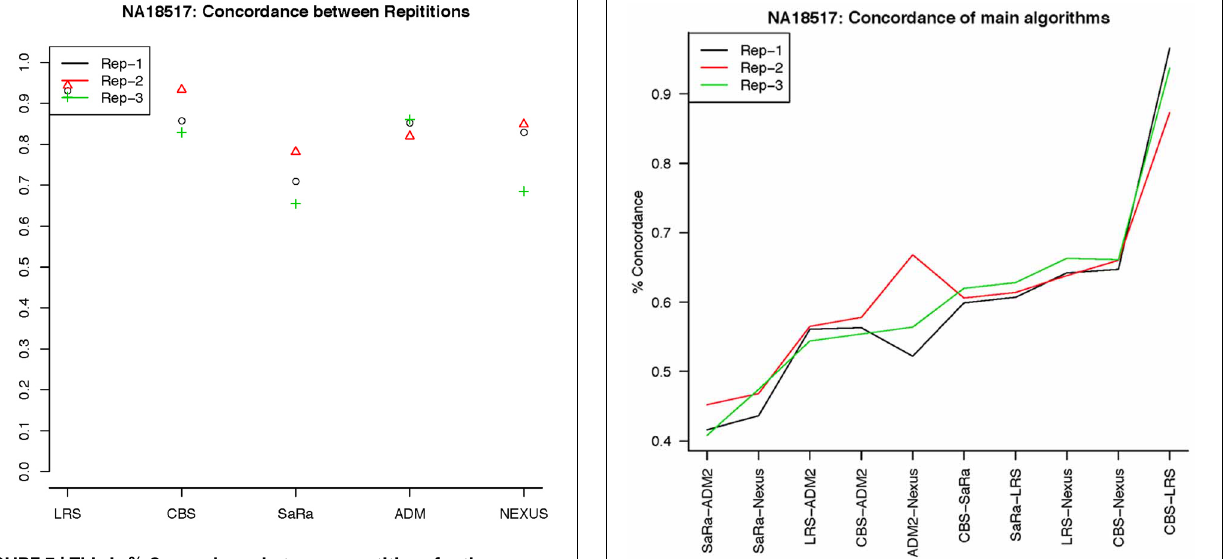
FIGURE 7 | This is % Concordance between repetitions for the same method for NA18157. Each sample was measured in triplicate so the probes declared CNV from one method on a repetition are compared to the probes declared as a CNV from the same method on a different repetition.